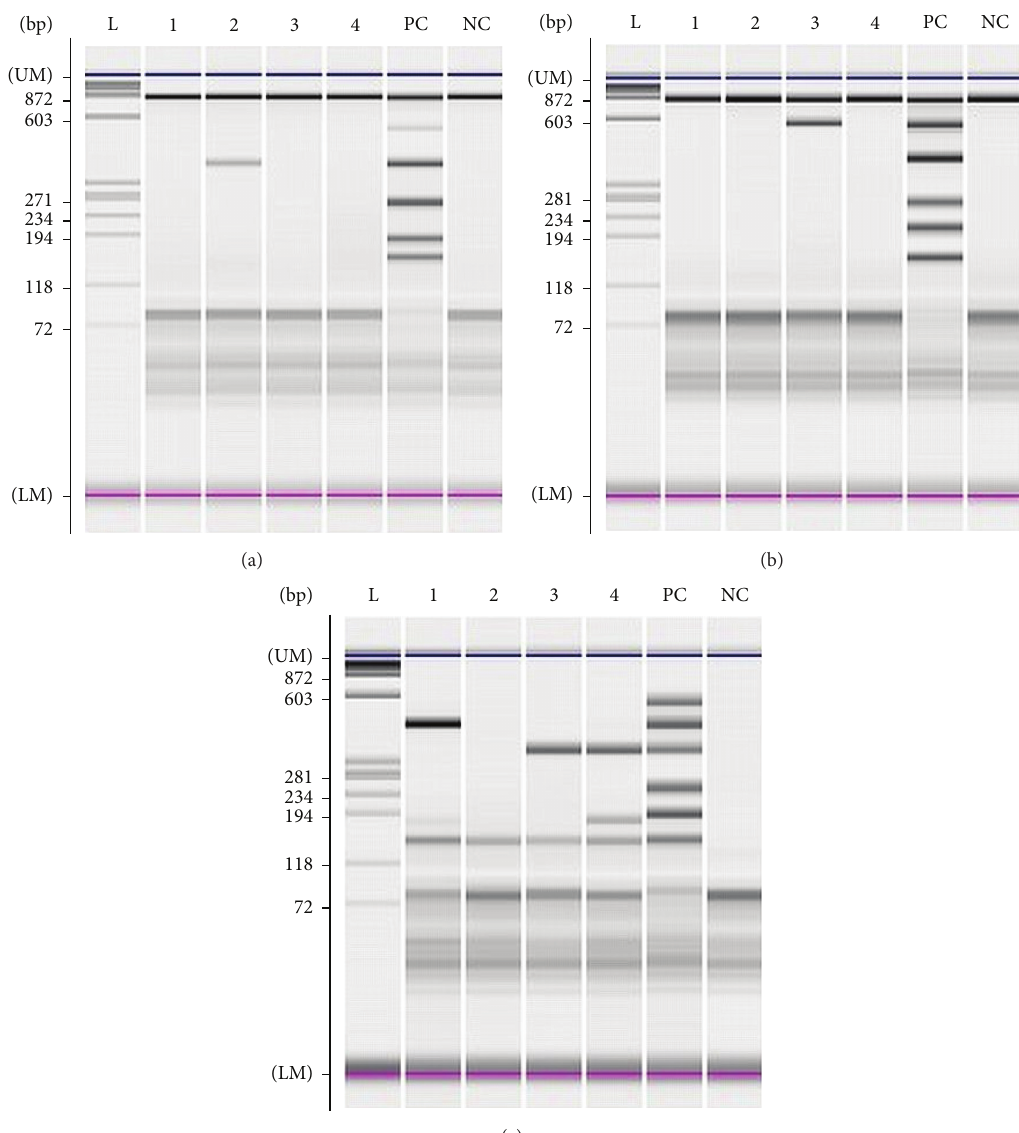
Figure1:Gelimageofelectropherogramfor(a), (b),and(c)setsofSeeplex (cid:3)